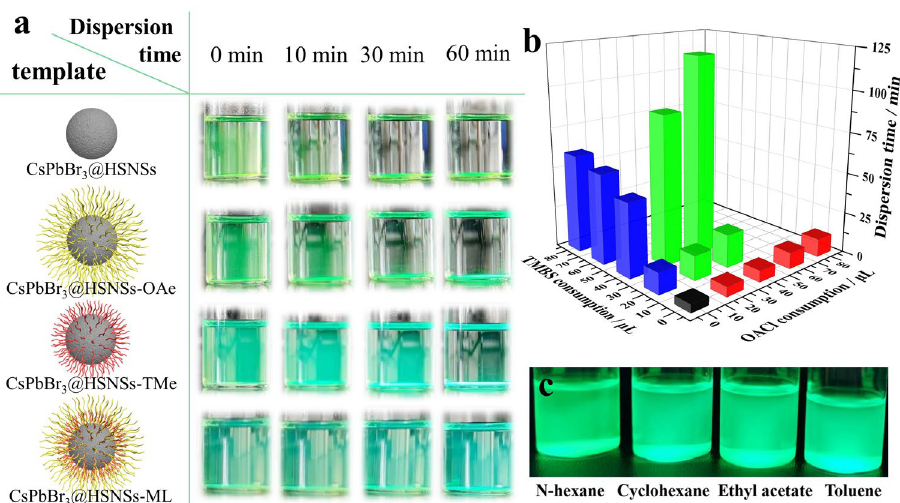
Figure 5. ( a ) Photos of CsPbBr 3 @HSNSs-Grafted during different static time periods under a 365 nm UV lamp; ( b ) settlement velocity of CsPbBr 3 @HSNSs-Grafted when HSNSs are grafted by different ligand dosages; ( c ) dispersive capacity of CsPbBr 3 @HSNSs-ML in a variety of non-polar solvents.